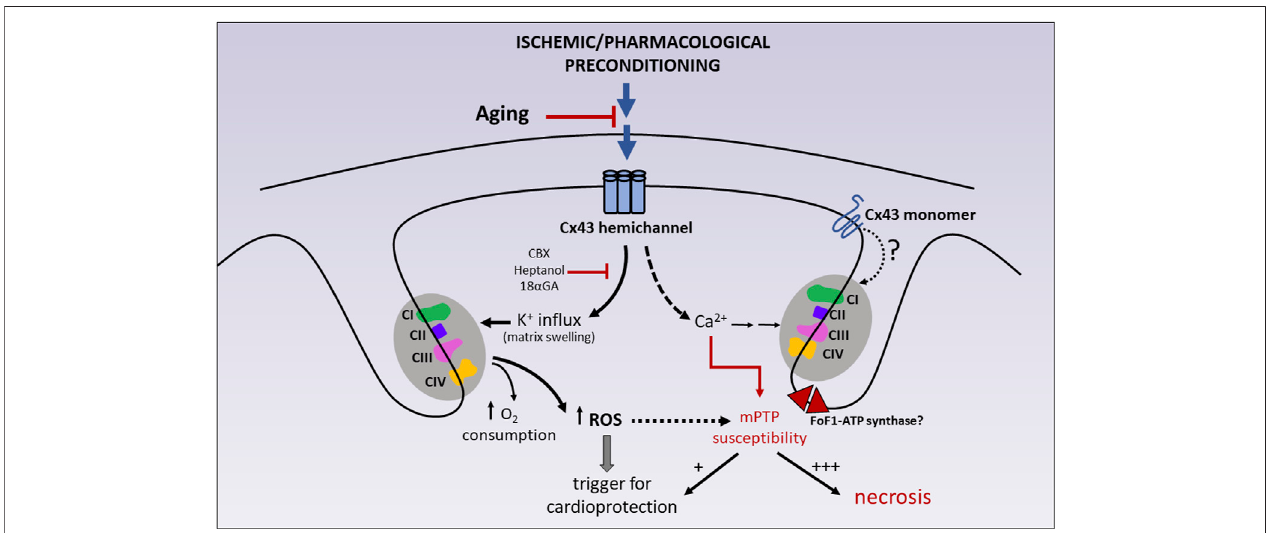
FIGURE 3 | Participation of mitochondrial Cx43 on cardioprotection and tolerance to IR injury. Ischemic preconditioning (IPC) and some pharmacological preconditioning strategies (diazoxide) have been shown to reduce cell necrosis after IR injury by stimulating mitochondrial K + entry via Cx43 hemichannels and, concomitantly, mitochondrial respiration and ROS generation. Due to the absence of direct patch clamp studies on Cx43-formed channels in mitoplasts (i.e., mitochondria in which the outer membrane has been removed), the possibility that monomeric Cx43 also plays a role in the activation of the respiratory enzymes cannot be ruled out. Transient ROS production acts as a trigger of cardioprotective signaling. These effects can be abrogated by chemically unrelated hemichannel blockers, like heptanol, carbenoxolone (CBX) and 18-alpha-glycyrrhetinic (18 α GA). Mitochondrial Cx43 hemichannels are also suggested to be calcium permeable, therefore participating in the homeostasis of mitochondrial calcium, a well-known sensitizer of mPTP opening. Whereas transient mPTP (+) may itself participateinpreconditioningprotection,sustainedmPTP(+++)uncouplesmitochondrialrespirationandprecipitatesmitochondrialswelling,membraneruptureandcell necrosis. CI-CII-CIII-CIV: mitochondrial respiratory complexes (I – IV). | − : inhibition; for further details see